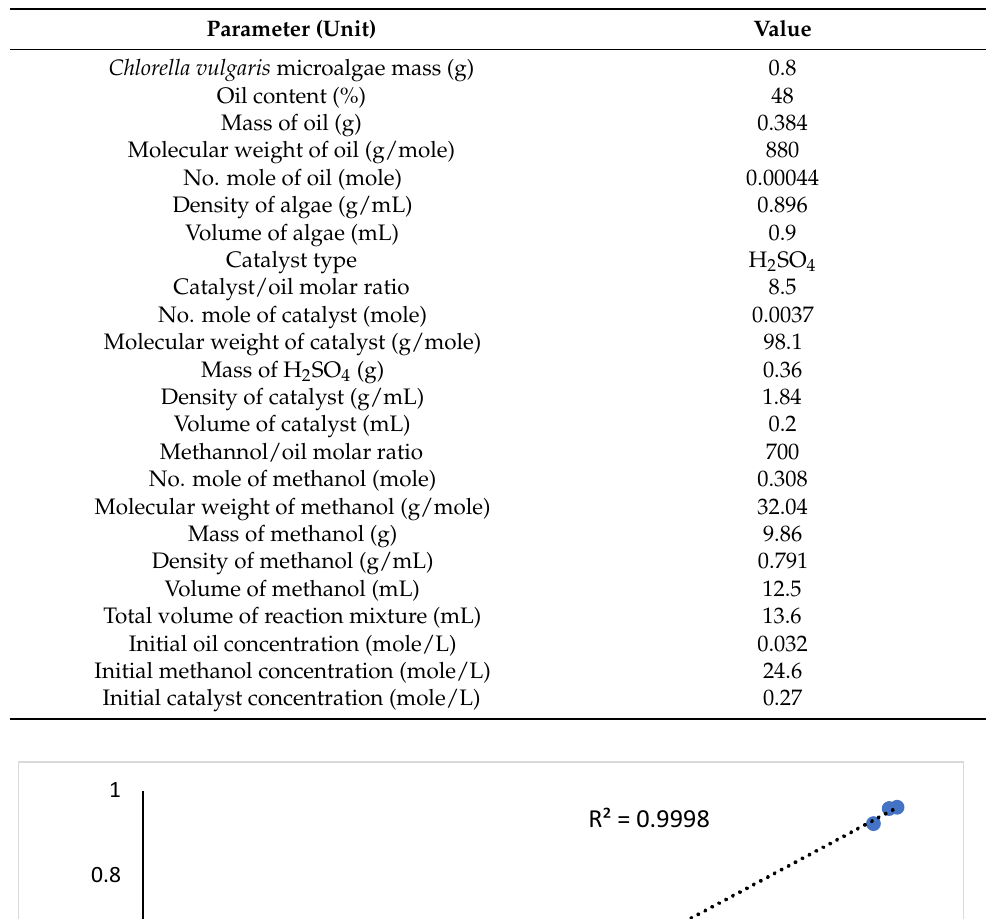
Table 2. Calculation of data required for kinetic investigation.